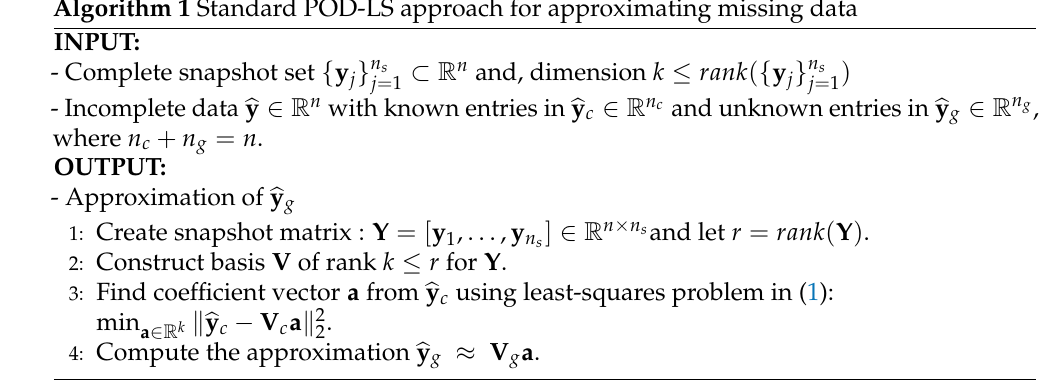
Algorithm 1 Standard POD-LS approach for approximating missing